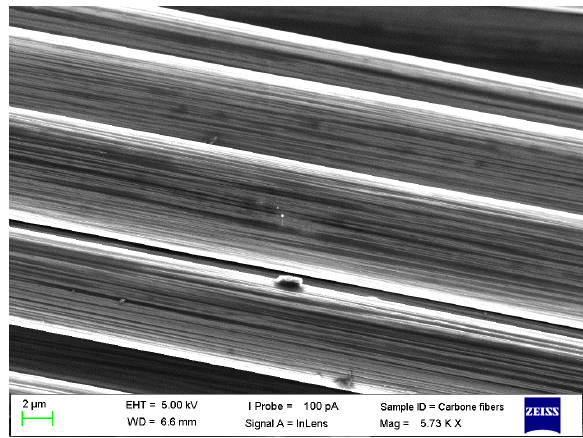
Figure 3. Carbon fiber fabric magnified 5.7k ×